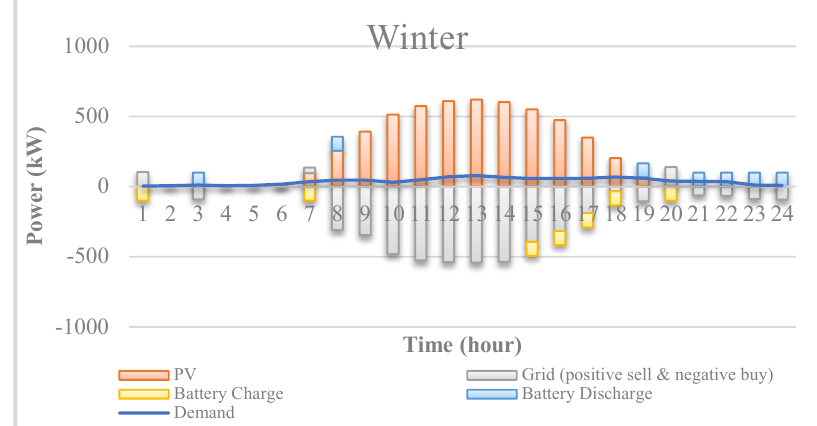
Figure 14. The bidding power of the VPP in winter.